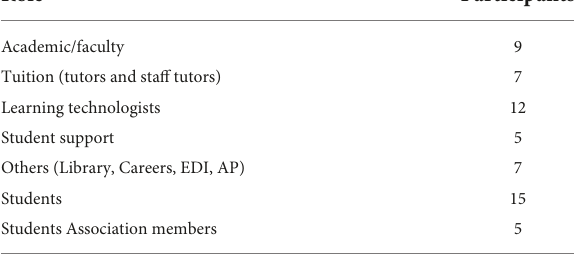
TABLE 4 Open University Mental Health project staff survey respondents’